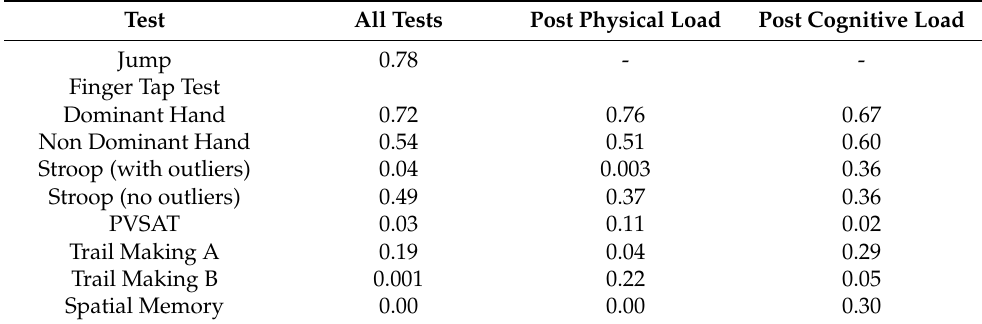
Table 2. Performance test sensitivity, R2, to the protocol load.